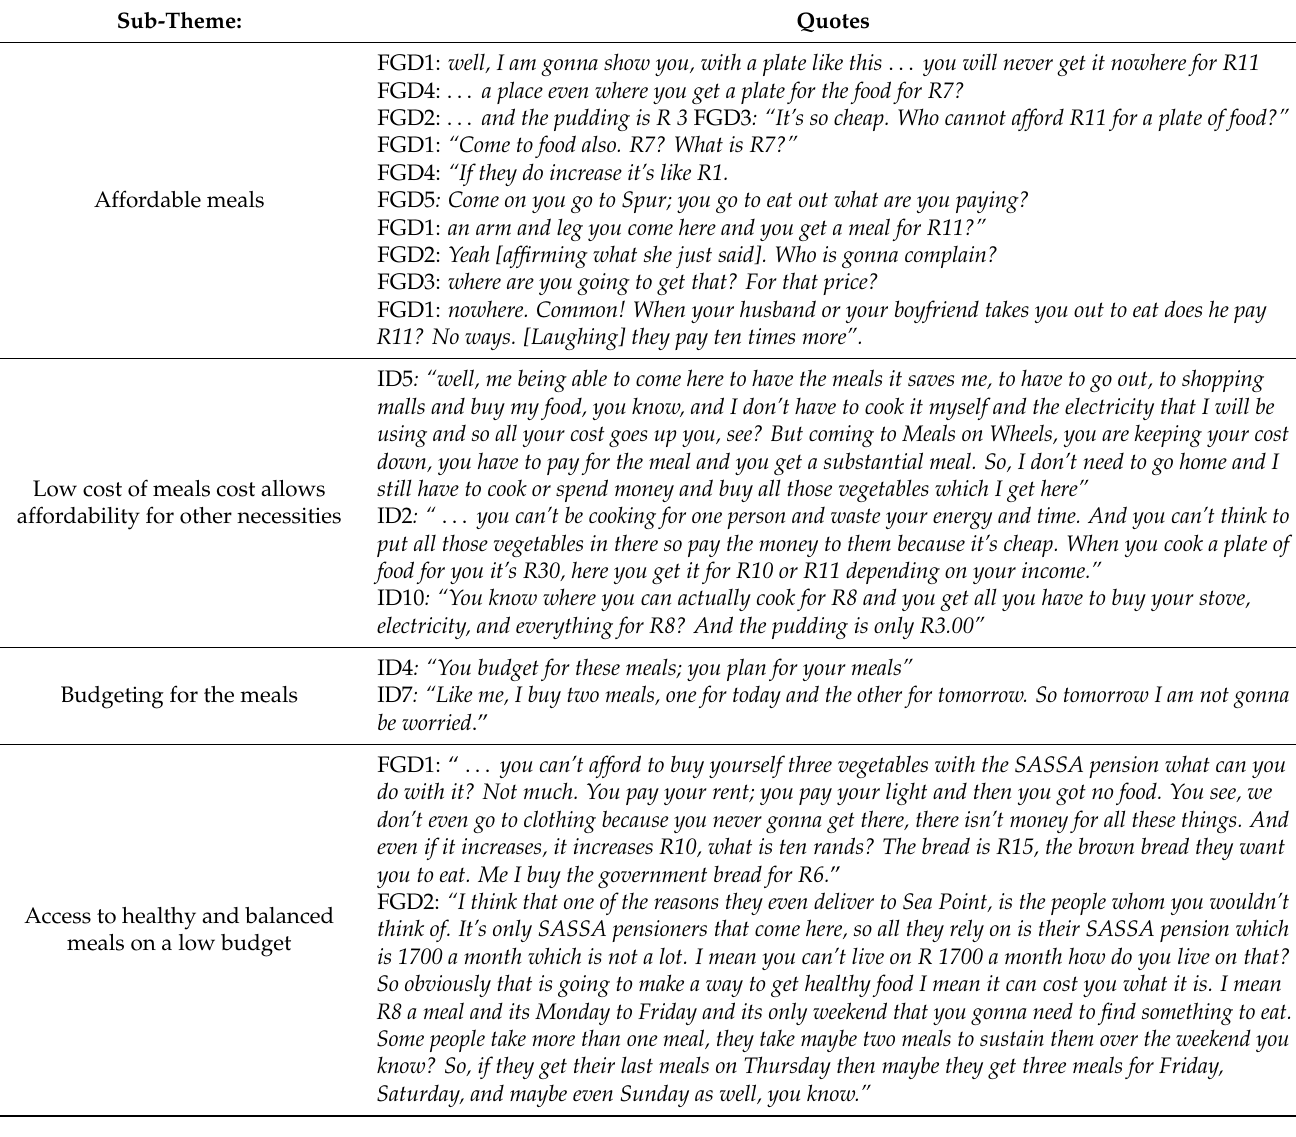
Table 5. Outcomes of food access, obtained from in-depth interviews and the focus group